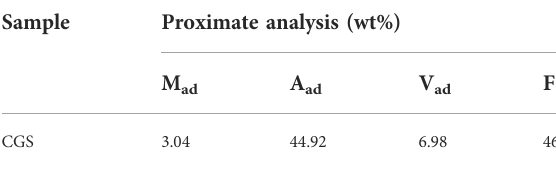
TABLE 1 Basic characteristics of coal gasi fi cation slag.